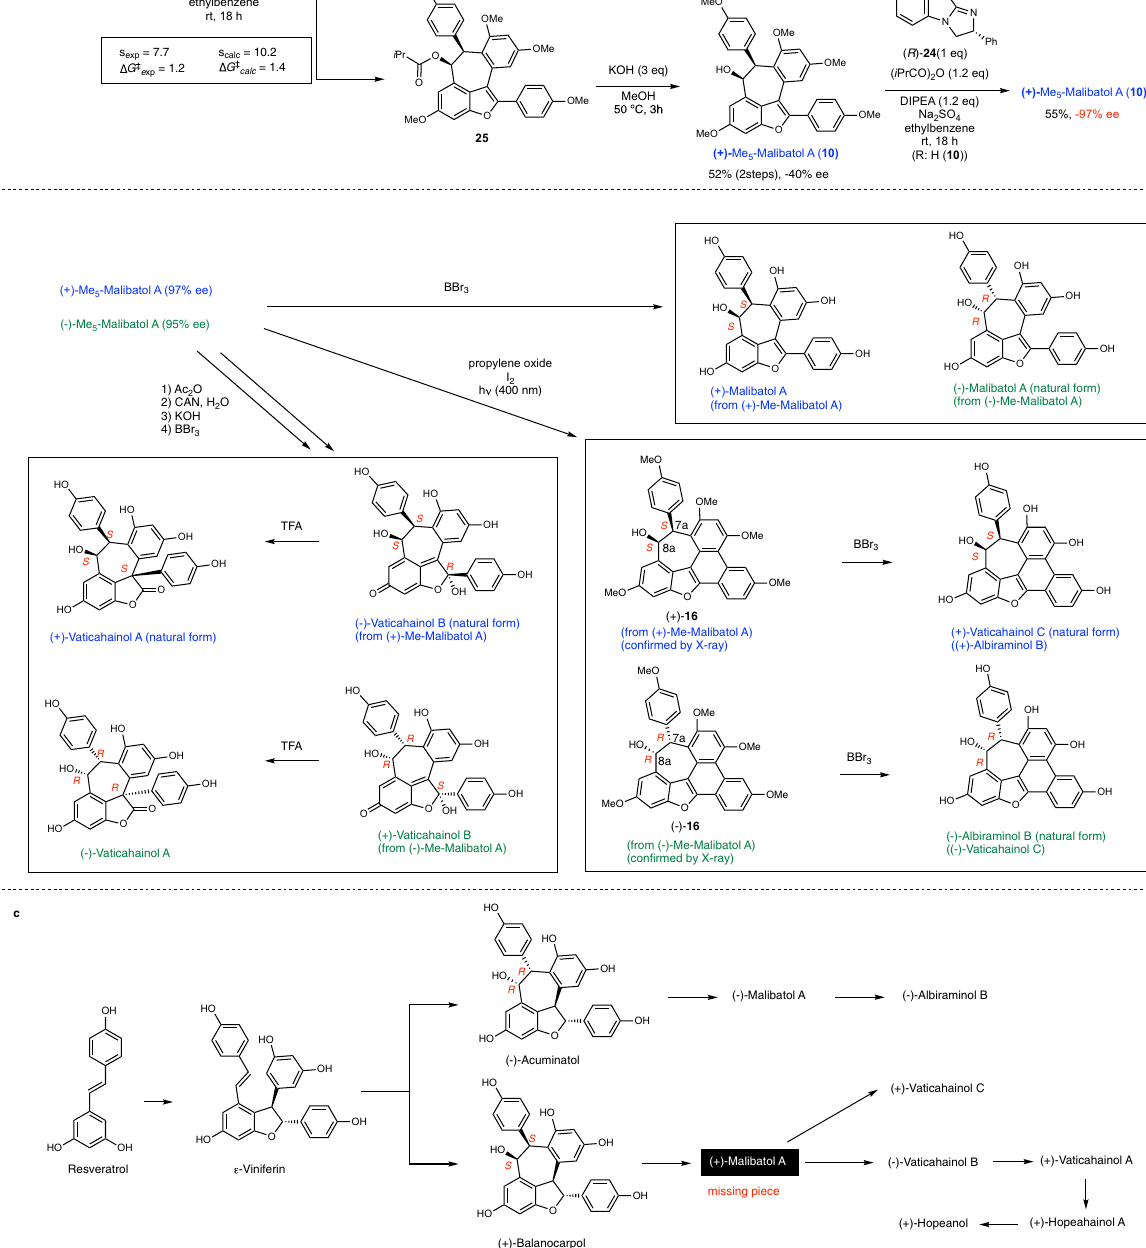
NATURE COMMUNICATIONS| (2022) 13:152